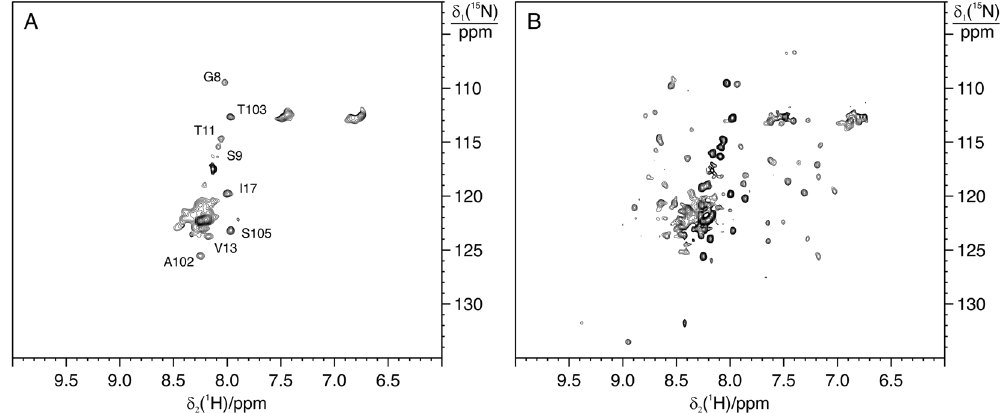
Figure 6. 15 N SOFAST-HMQC spectra of WT BIR1 in HEK293T cells and cell lysate. ( A ) On a sample of HEK293T cells expressing WT BIR1 and ( B ) on the corresponding cell lysate.